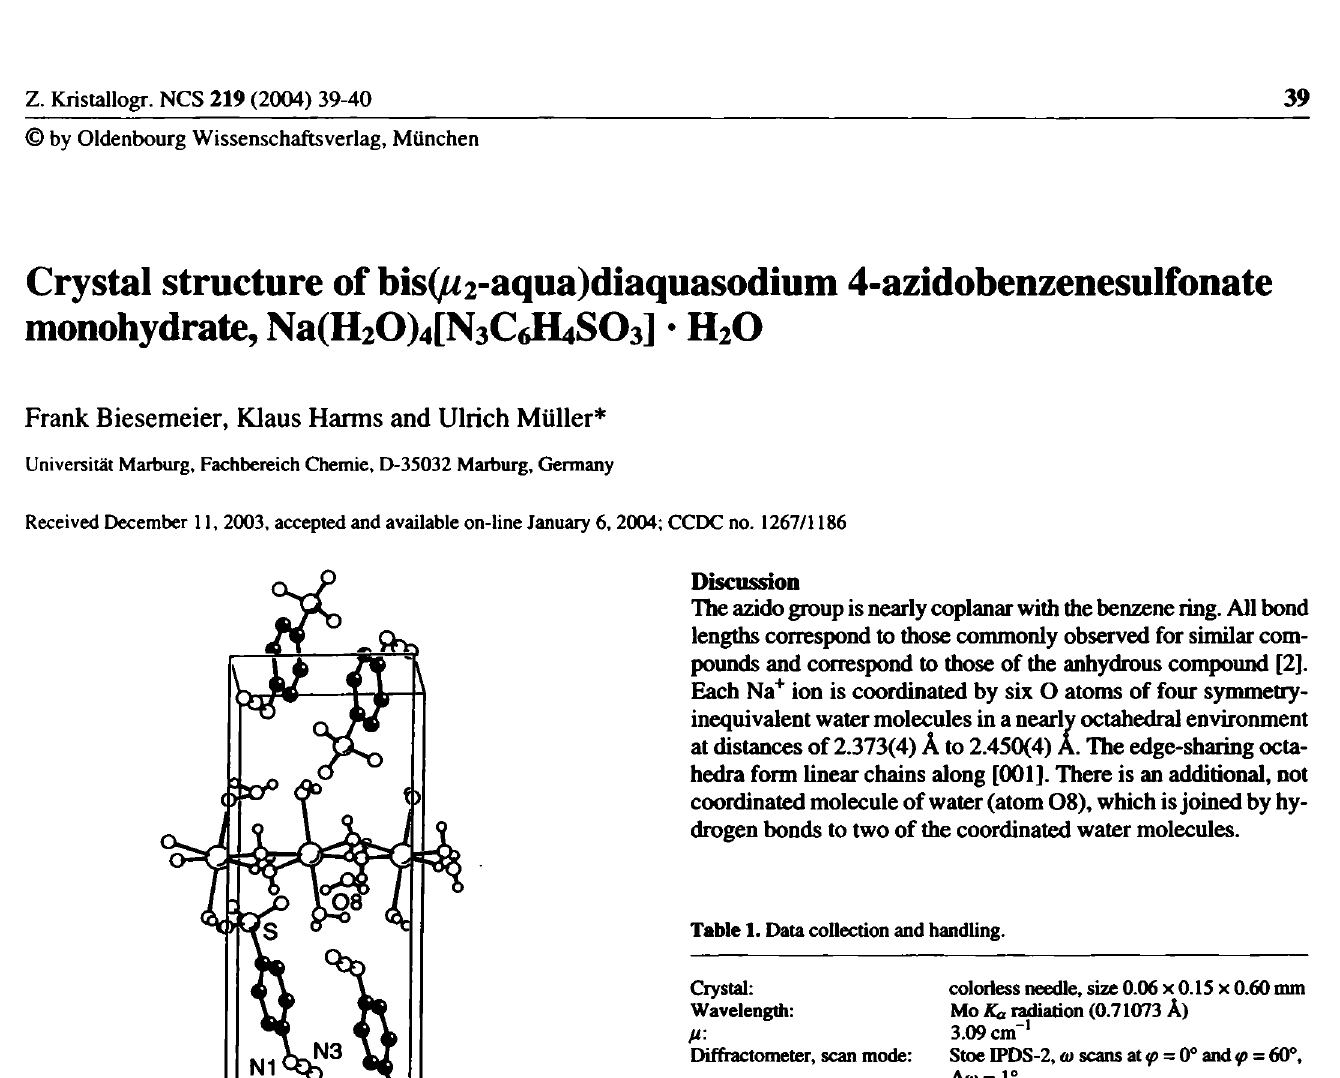
Table 2. Atomic coordinates and displacement parameters (in Â 2